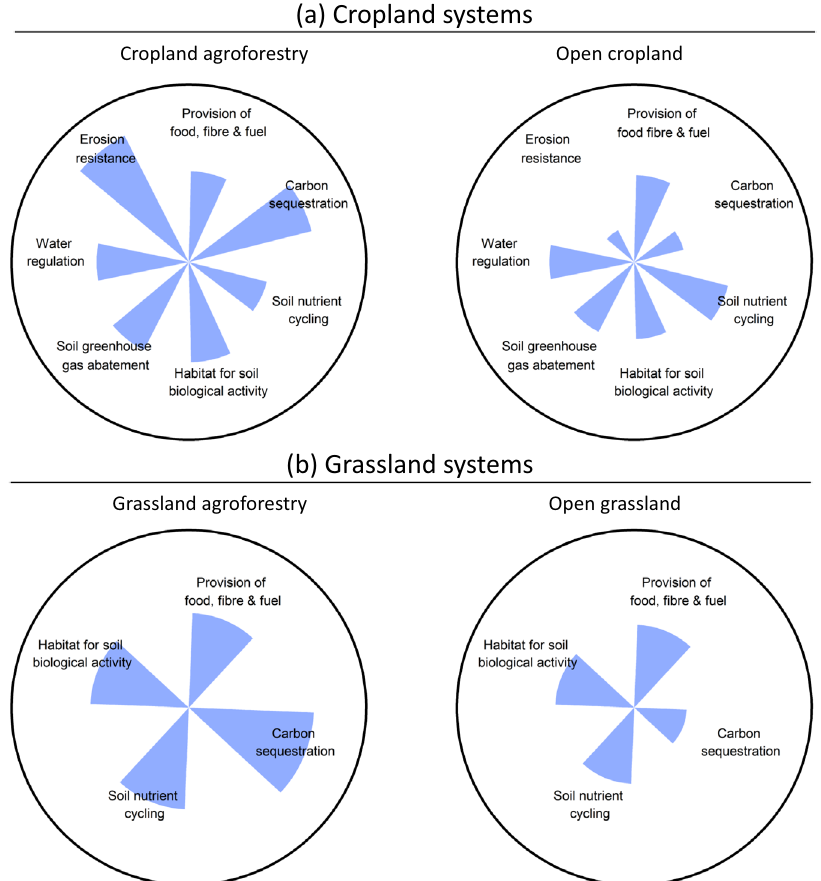
Fig. 3 Ecosystem functions in four management systems. Croplands at three sites ( a ; agroforestry and open cropland) and grasslands at two sites ( b ; agroforestry and open grassland) in Germany. The center point and outer solid black circle in each panel represent the 5th and 95th quantiles, respectively; the length of the bars represents the mean of the z -standardized values of indicators for a speci fi c ecosystem function. Mean, standard error, and N values of indicators are given in Supplementary Table